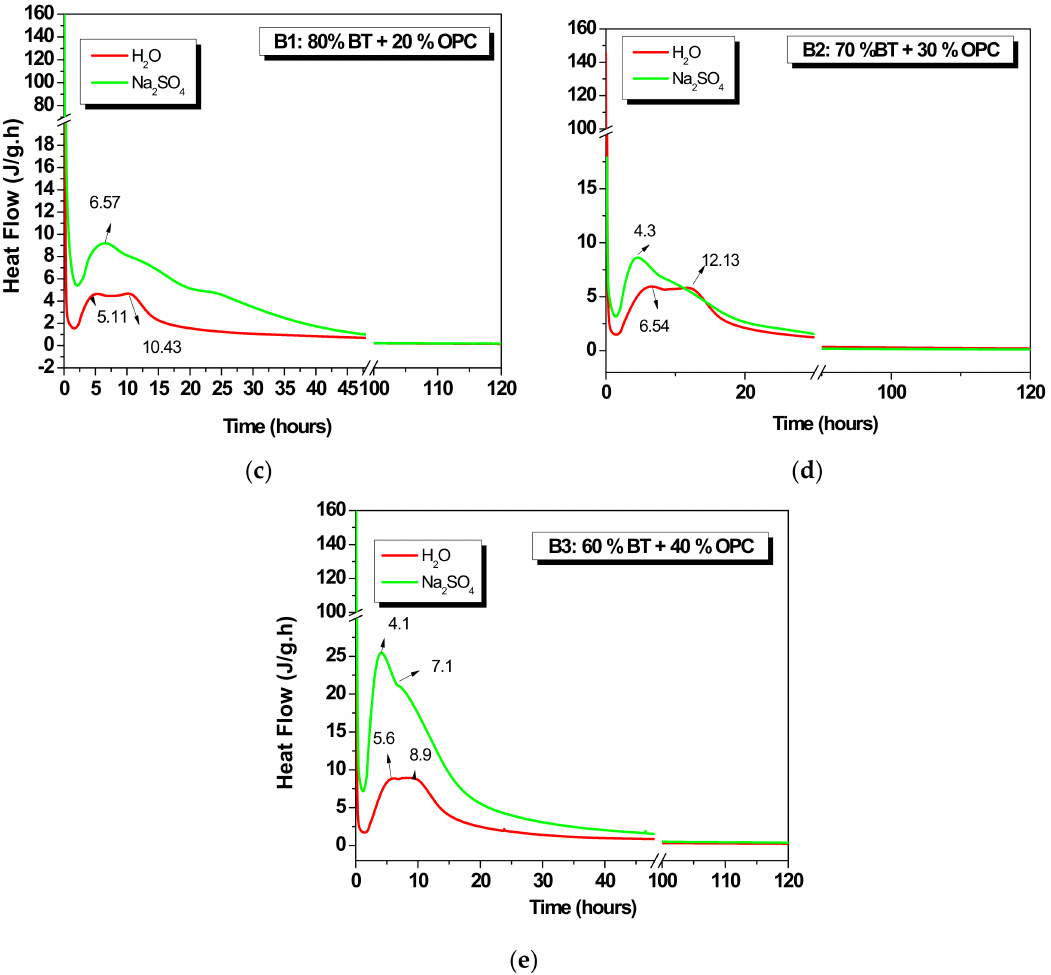
Figure 1. Heat Flow evolution (J/g · h) of hydrated and alkali activated hybrid cements ( a ) BT (100% BT); ( b ) OPC (100% OPC); ( c ) B1 (80% BT + 20% OPC); ( d ) B2 (70% BT + 30% OPC) and ( e ) B3 (60% BT + 40% OPC).